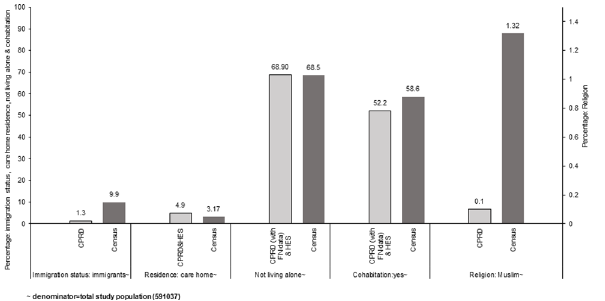
Fig 3. Comparing recording of immigration status, care home residence, not living alone, cohabitation and religion in electronic health records and English Census 2011. Abbreviations CPRD ClinicalPractice ResearchDatalinkHES Hospital EpisodeStatistics FN family